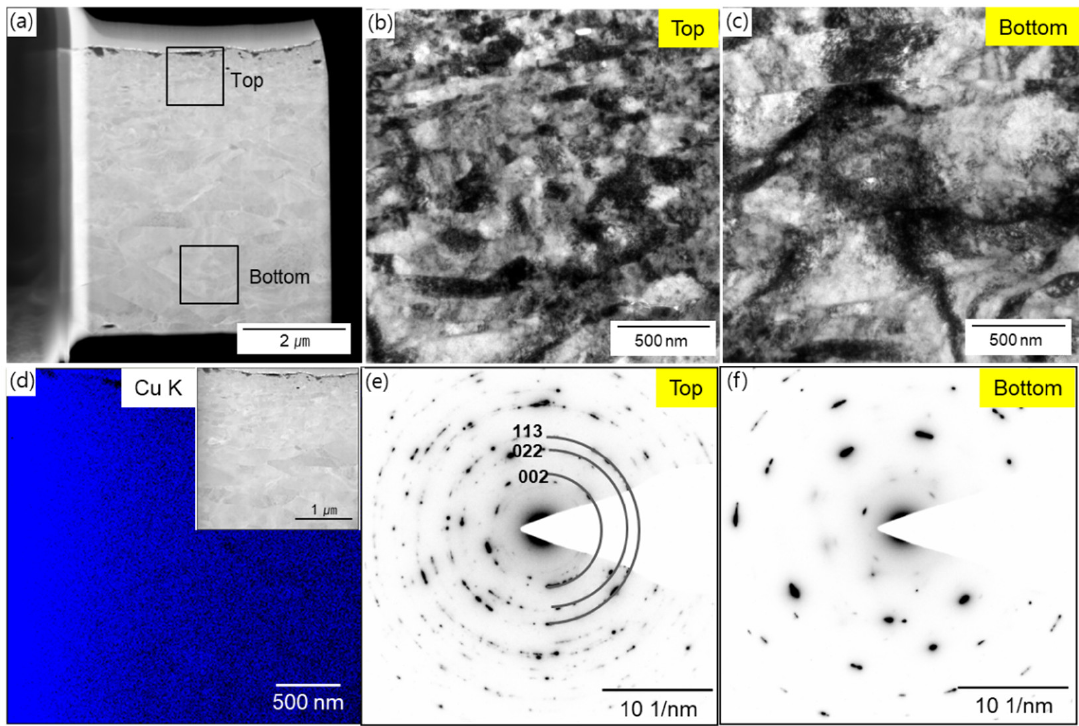
Figure 5. Transmission electron microscopy (TEM) images of Cu-based brake pads: ( a ) cross-section view of 600-20 sample and ( b , c ) TEM images of top and bottom regions of sample in ( a ). ( d ) EDS results for cross-section of sample in ( a ) and ( e – f ) SADP analysis results of top and bottom regions of sample in ( a ).